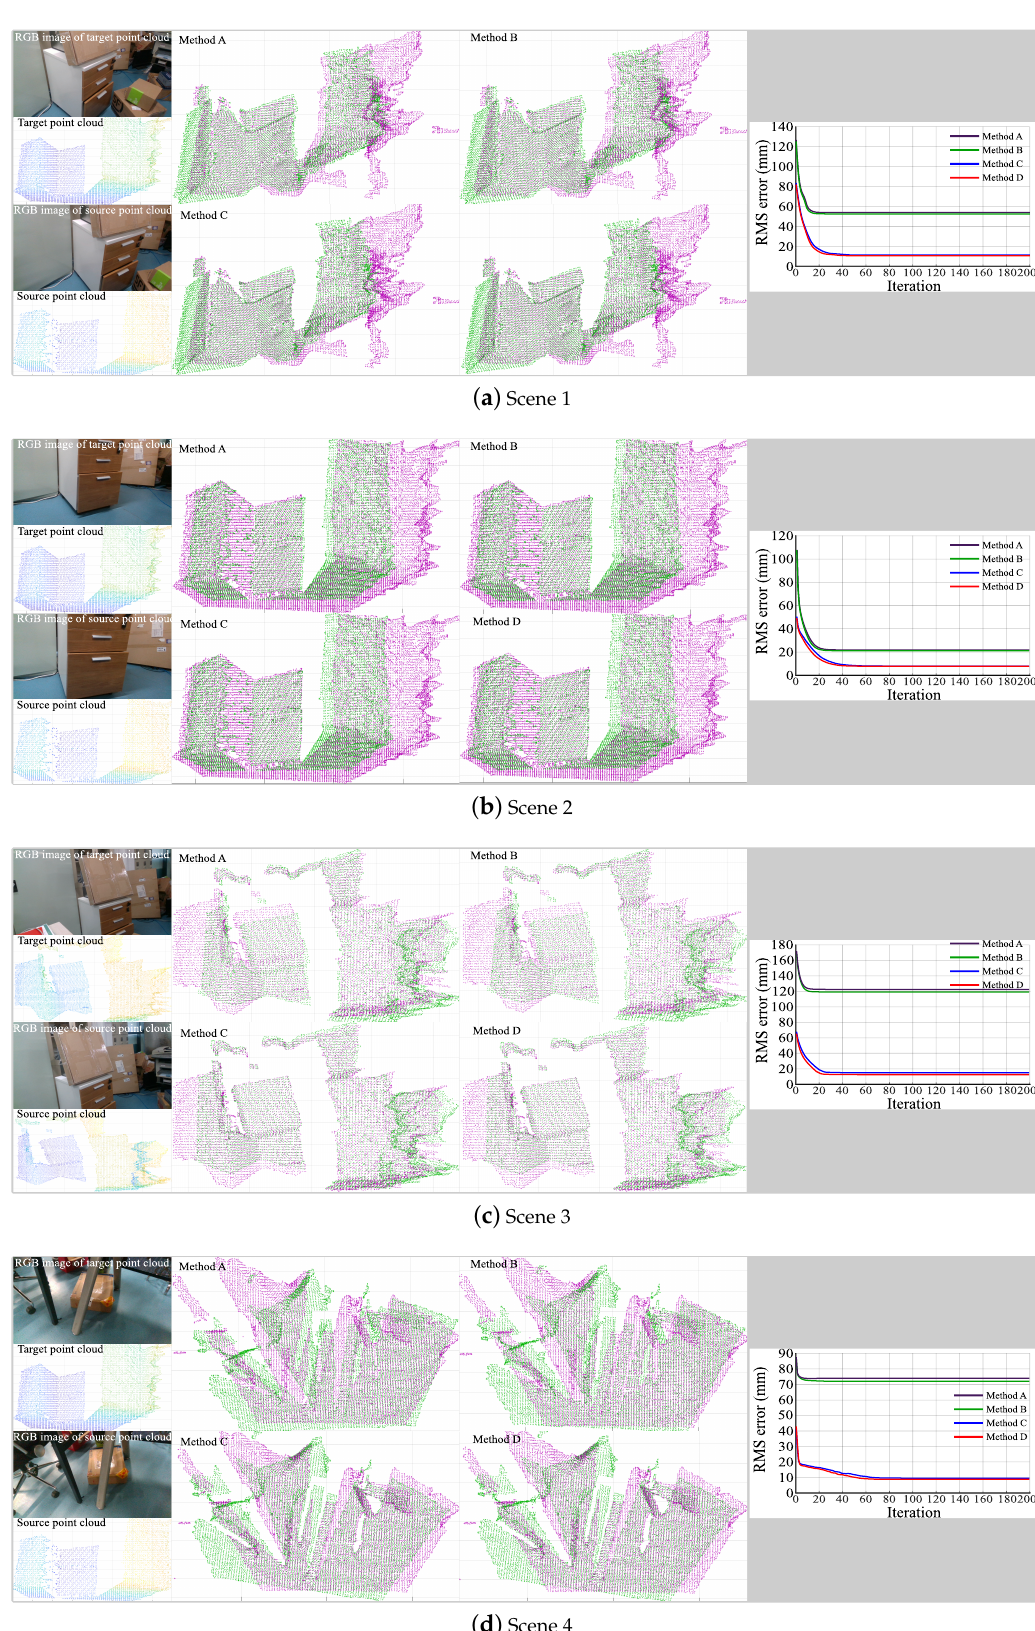
Figure 5. Comparison of point cloud registration results with different methods. Method A : original ICP algorithm, Method B : ICP algorithm with weighting, Method C : ICP algorithm with Q point pairs, Method D : ICP algorithm weighted by Q point